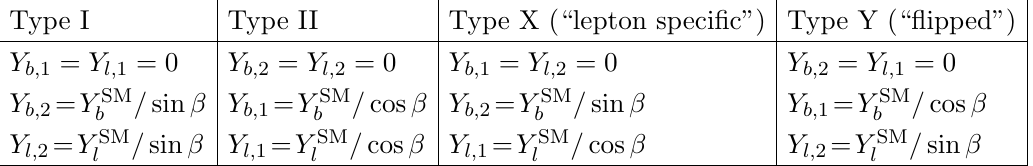
Table 1 . Yukawa coupling assignments in the four possible Z 2 symmetric 2HDM